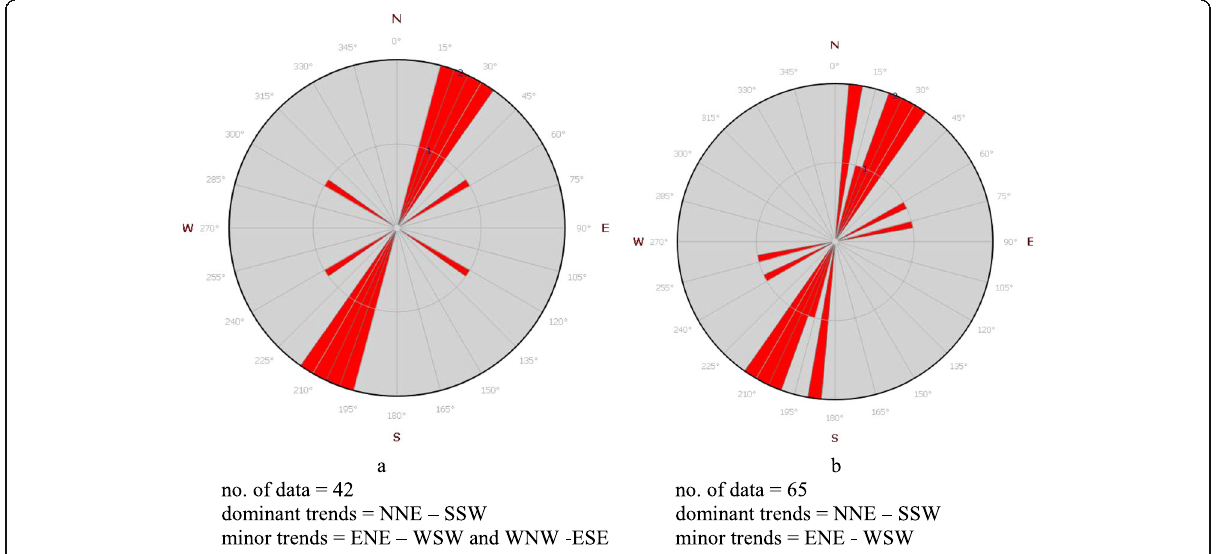
Fig. 12 Rose plot of veins on granitic gneiss and muscovite granite of the area. a Biotite muscovite granite. b Granitic